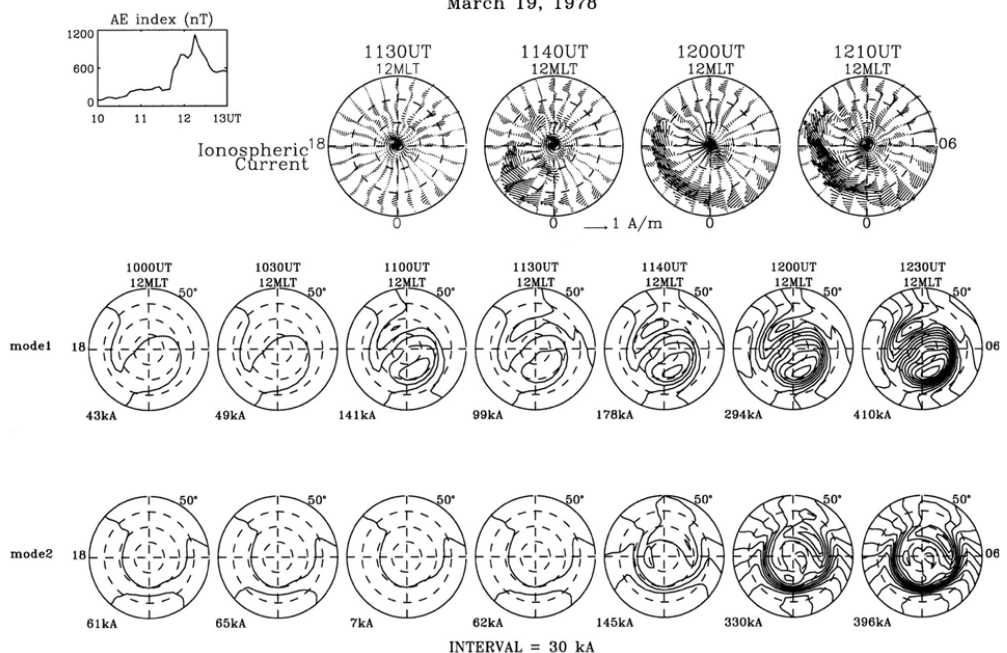
Fig. 3. From the top, the substorm current in the ionosphere, Mode 1 (DD) current and Mode 2 (UL) current (Sun et al., 1998). The AE index is shown on the upper left